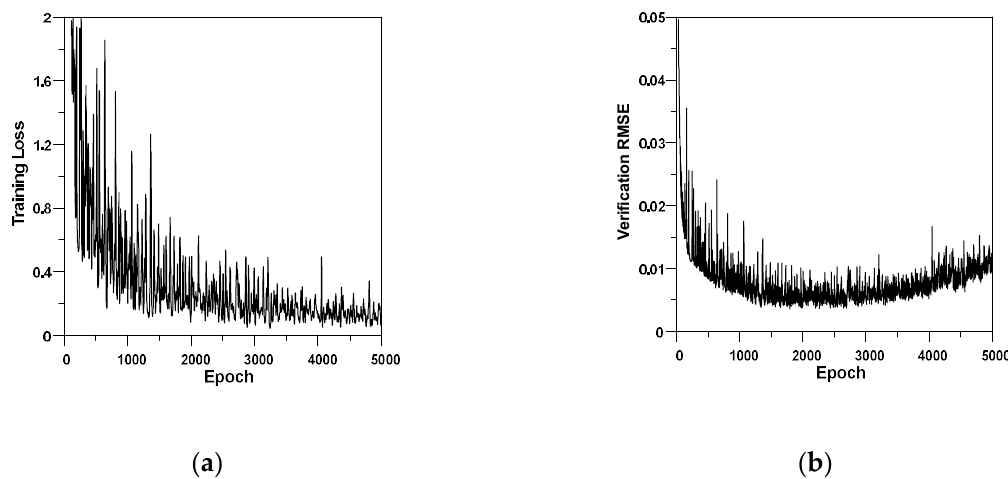
Figure 16. Error variation versus epoch: ( a ) Loss variation in training; ( b ) RMSE variation in verification.